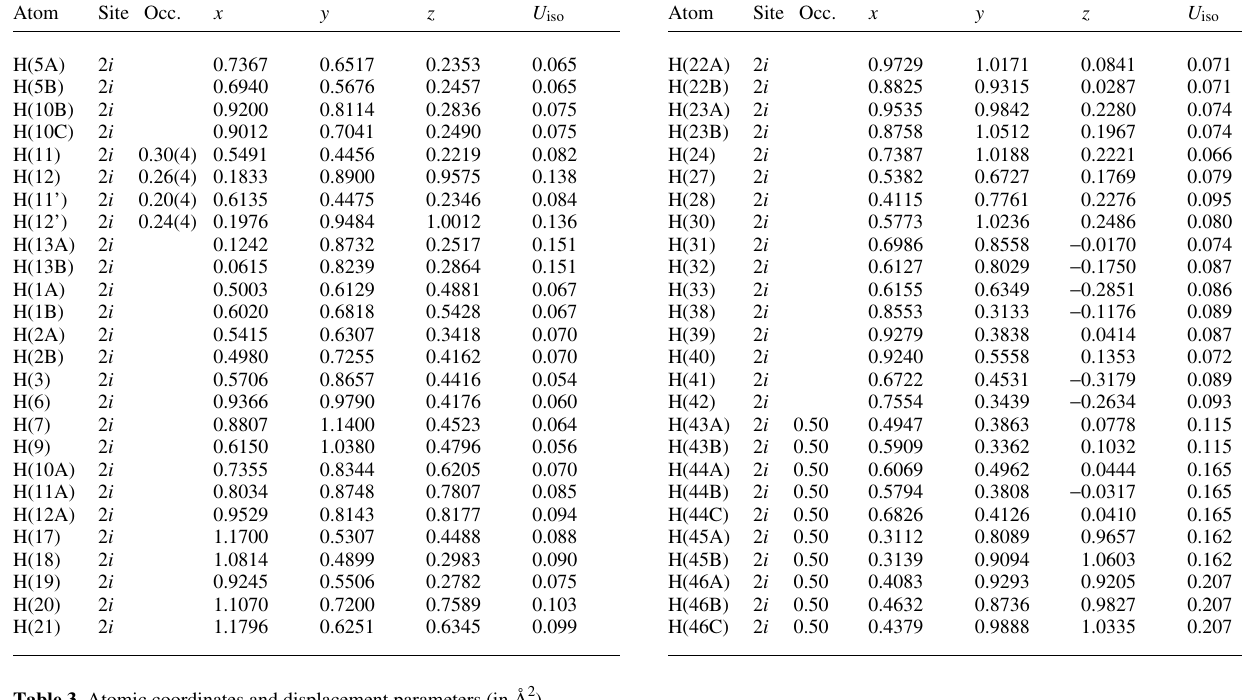
Table 2. Atomic coordinates and displacement parameters (in Å 2 ) . Atom Site